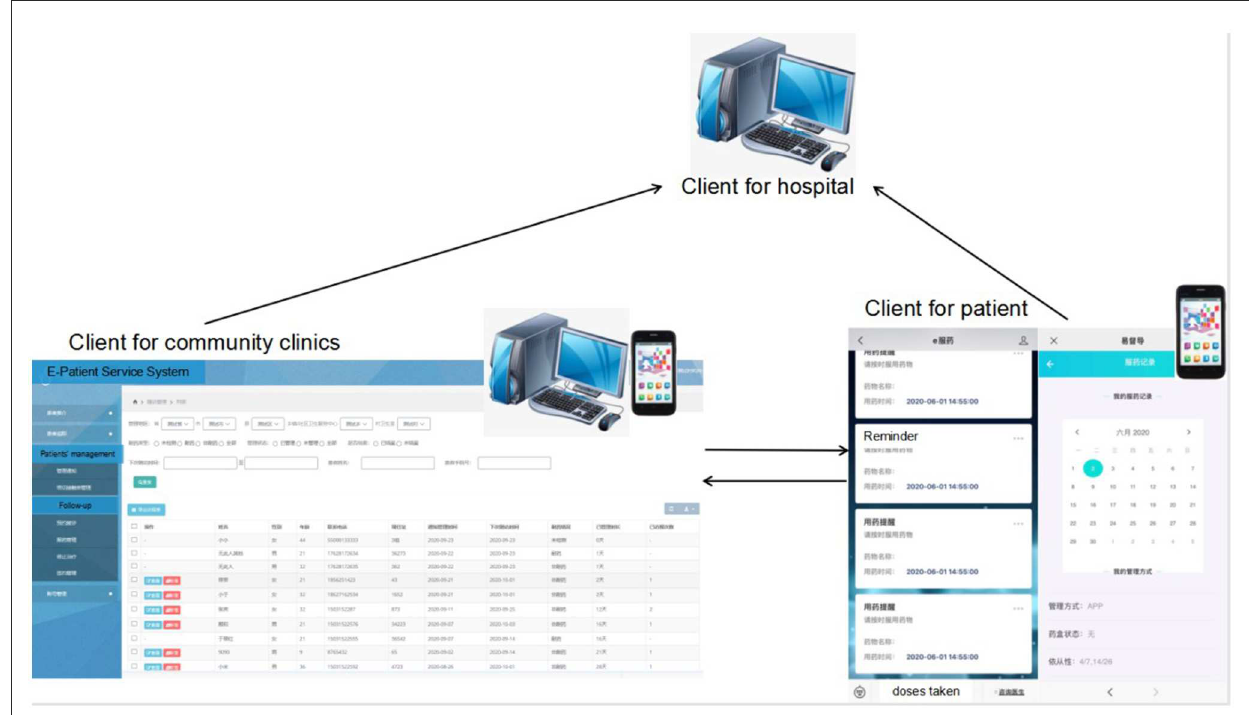
FIGURE1 E-Patient Service